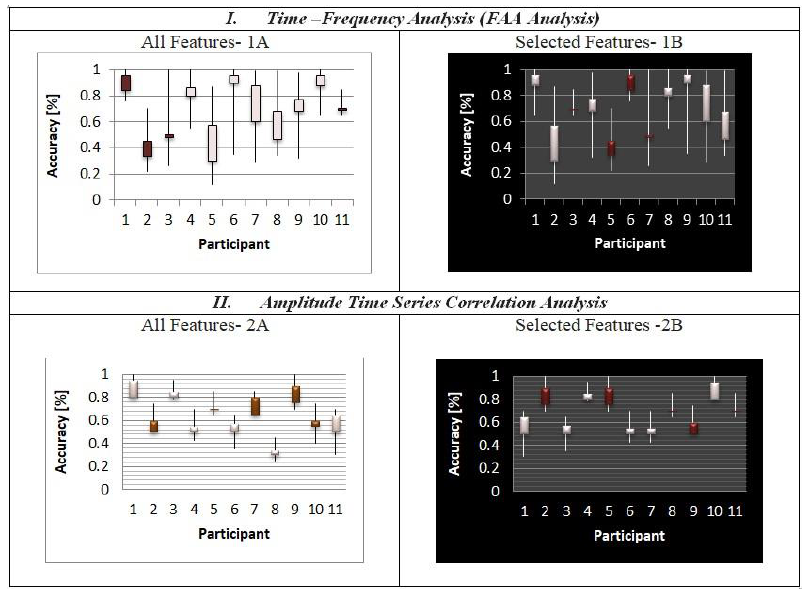
Figure 6. The outcome of classification using each feature extraction method’s 100 chosen features ( 1B , 2B ) and all available features ( 1A , 2A ), respectively.